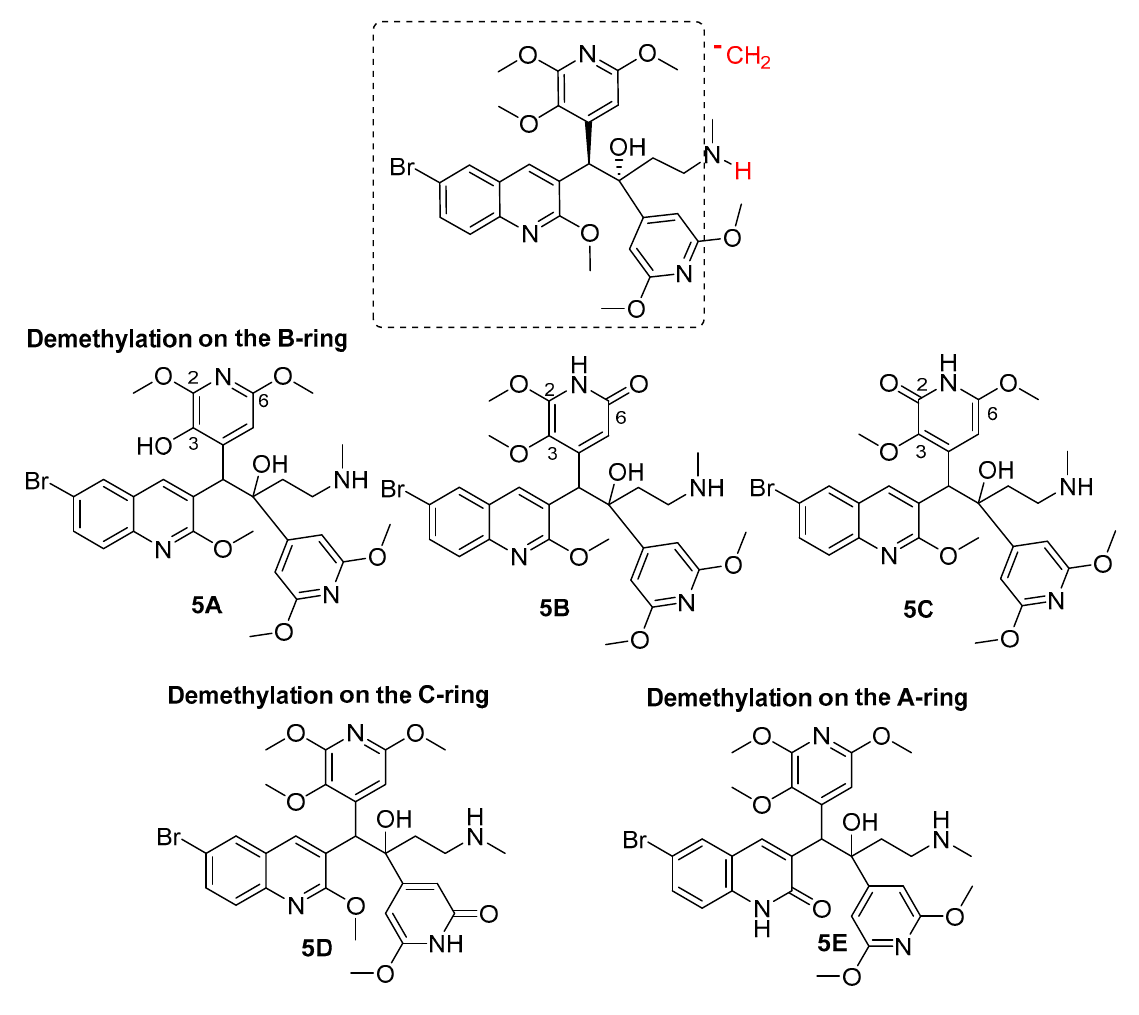
Figure 2. Five possible structures of metabolite 5.